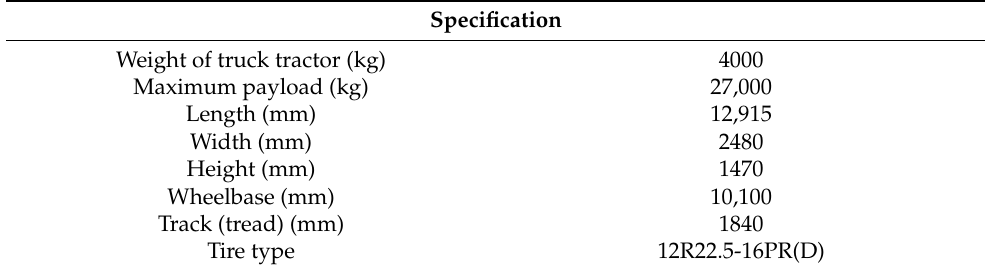
Table 1. Main specification of the tube skid trailer.